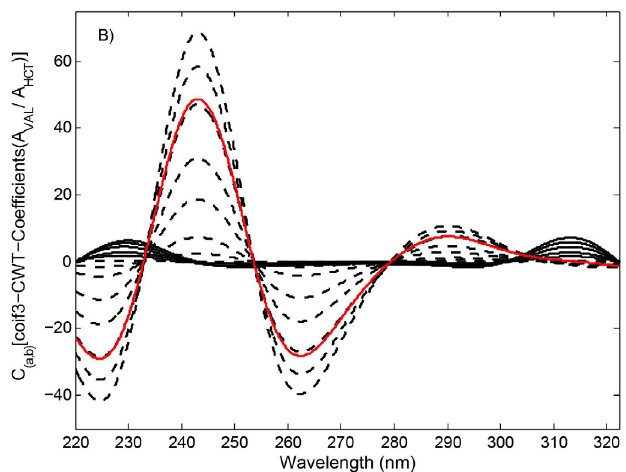
FIGURE 3B - RS-coif3-CWT spectra of VAL (----) : 1.0, 3.0, 9.0, 15.0, 21.0, 27.0, 33.0 µ g/mL and HCT (  ) : 1.0, 6.0, 11.0, 16.0, 21.0, 26.0 µ g/mL and tablet sample (  ) containing 2.50 µ g/mL of VAL and 16.0 µ g/mL of HCT.